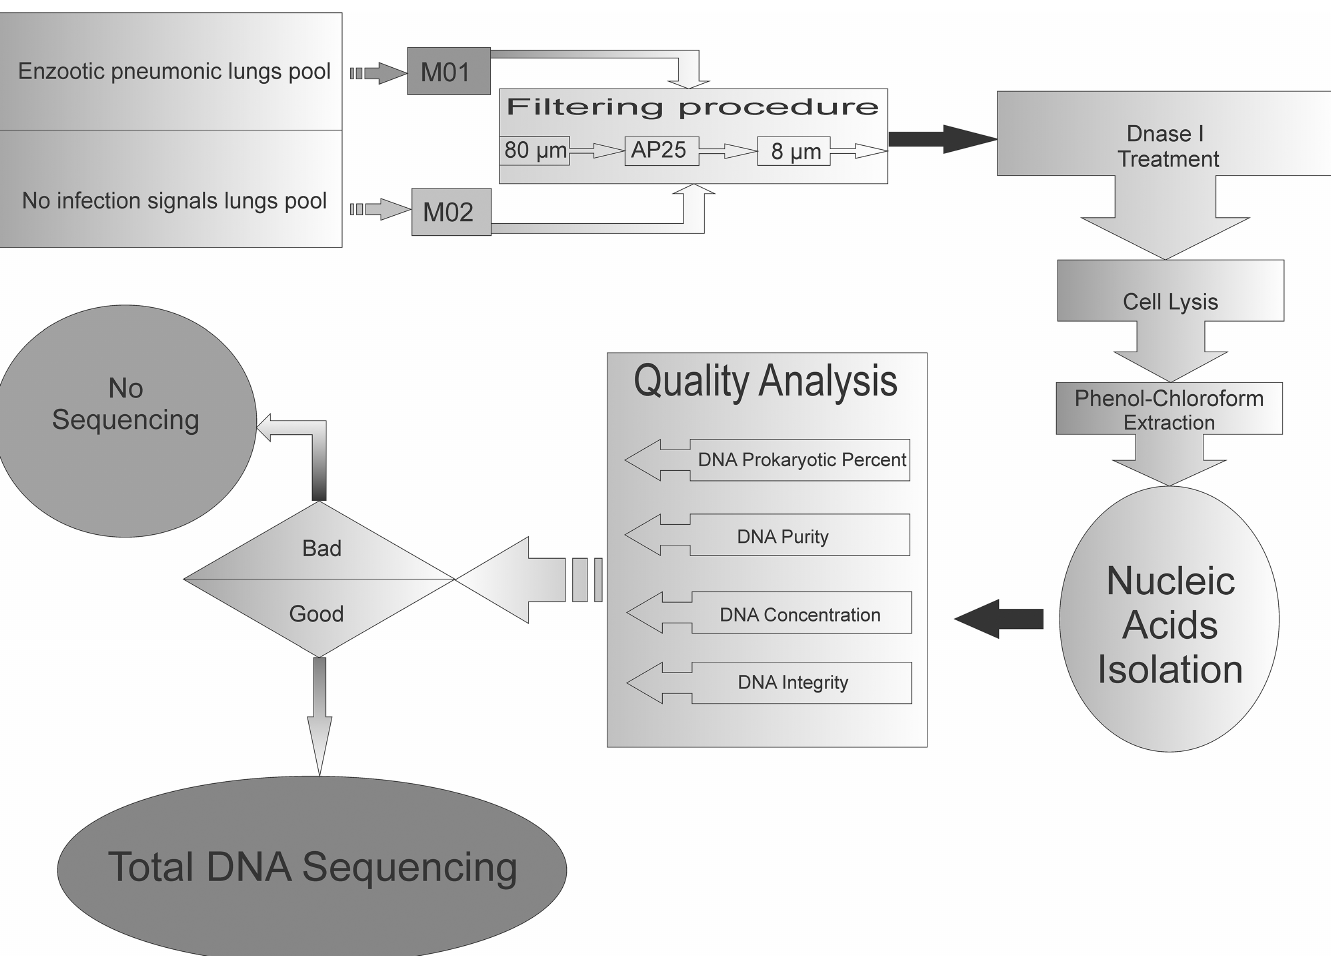
Fig 1. Workflow of samples preparation for metagenomic sequencing. The figure shows the samples collection;bacteriacell selection;bacteriaDNA extraction and shotgunmetagenomic sequencing. M01: trachealand lungs lavagepool from 20 pneumonic lungs. M02: trachealand lungs lavagepool from 20 lungs without both swine enzooticpneumoniaand infectionmacroscopic